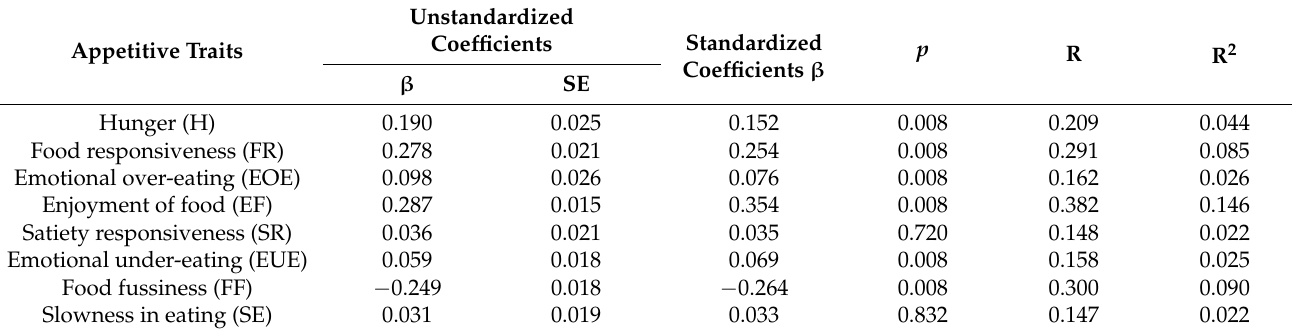
Table 8. Analysis of association between appetitive traits and dairy preference assessed by Food Preference Questionnaire (FPQ) (model adjusted for sex and age) within the population of the second phase of the Polish Adolescents’ COVID-19 Experience (PLACE-19) Study ( n =